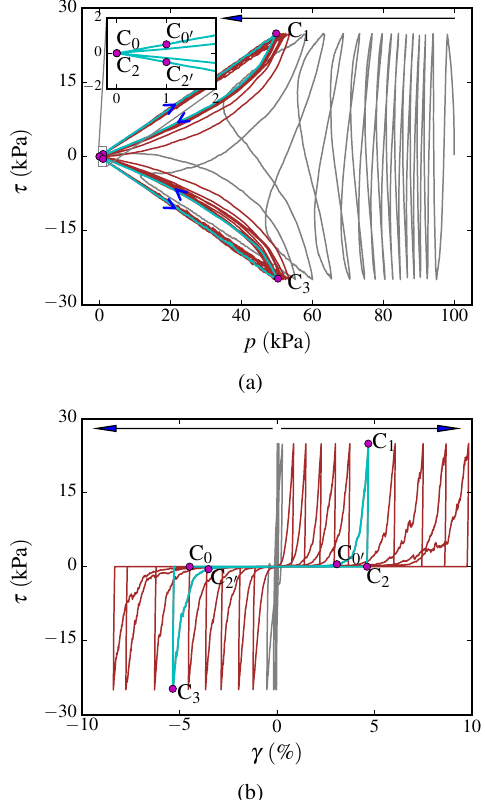
Figure 2: Macroscopic response of isochoric cyclic shear test: (a) stress path; (b) stress-strain curve.